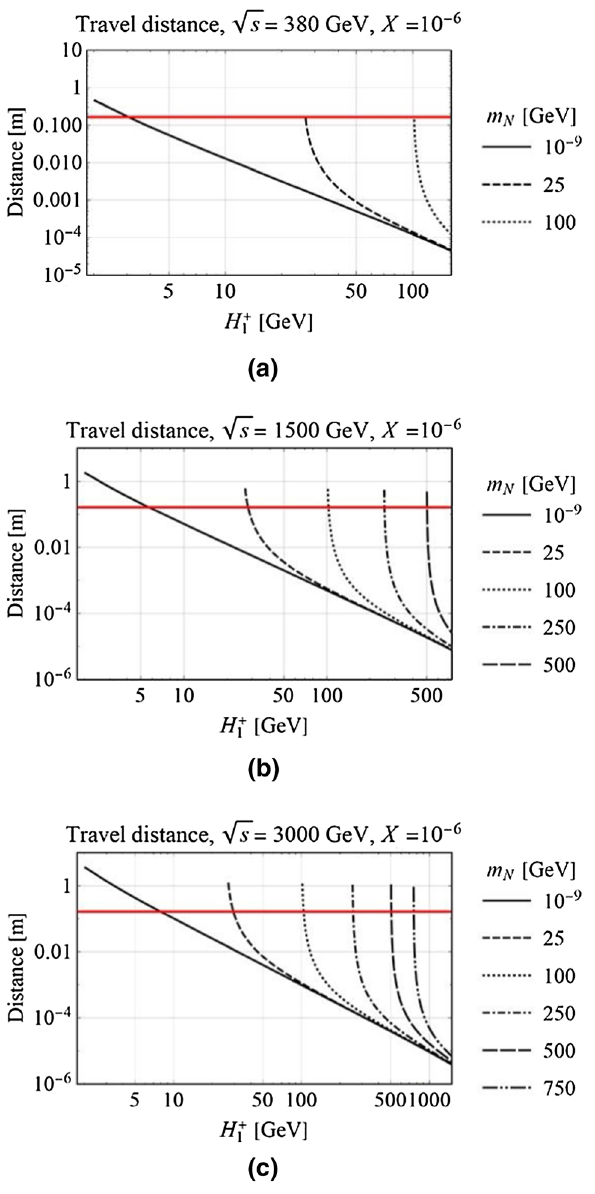
Fig. 6 H + travel distance. The graphs show the total travel distance of √ 1 H + for different values of m N and energy stages of CLIC ( a s : 380 √ √ 1 s : 1500 GeV, c s : 3000 GeV), considering X = 10 − 7 . The GeV, b red line indicates the innermost tracker layer distance at 165mm from the center